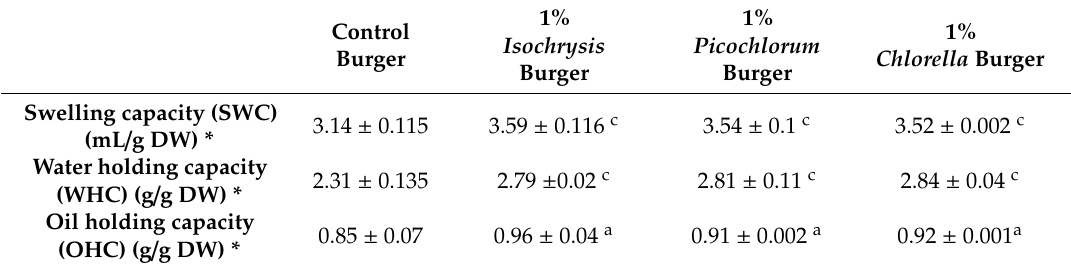
Table 4. Functional parameters of control and microalgae-fortified fish